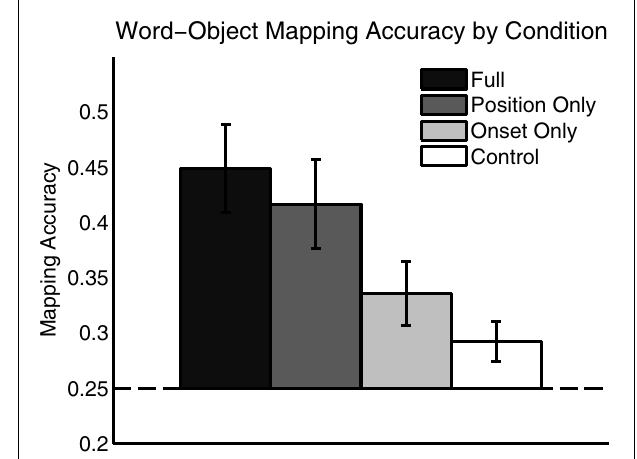
FIGURE 2 | Segmentation accuracy in each condition for both Object Labels and Frame words. Learners successfully segmented Object Labels in the Full and Position Only language conditions, and segmented Frame Words in the Onset Only language condition. Error Bars indicate ± 1 SE.